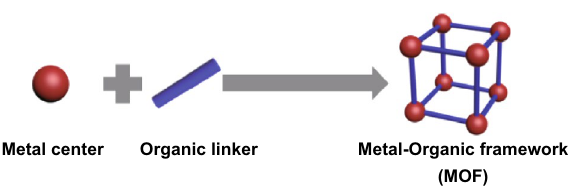
Fig. 1 Schematic structure of the